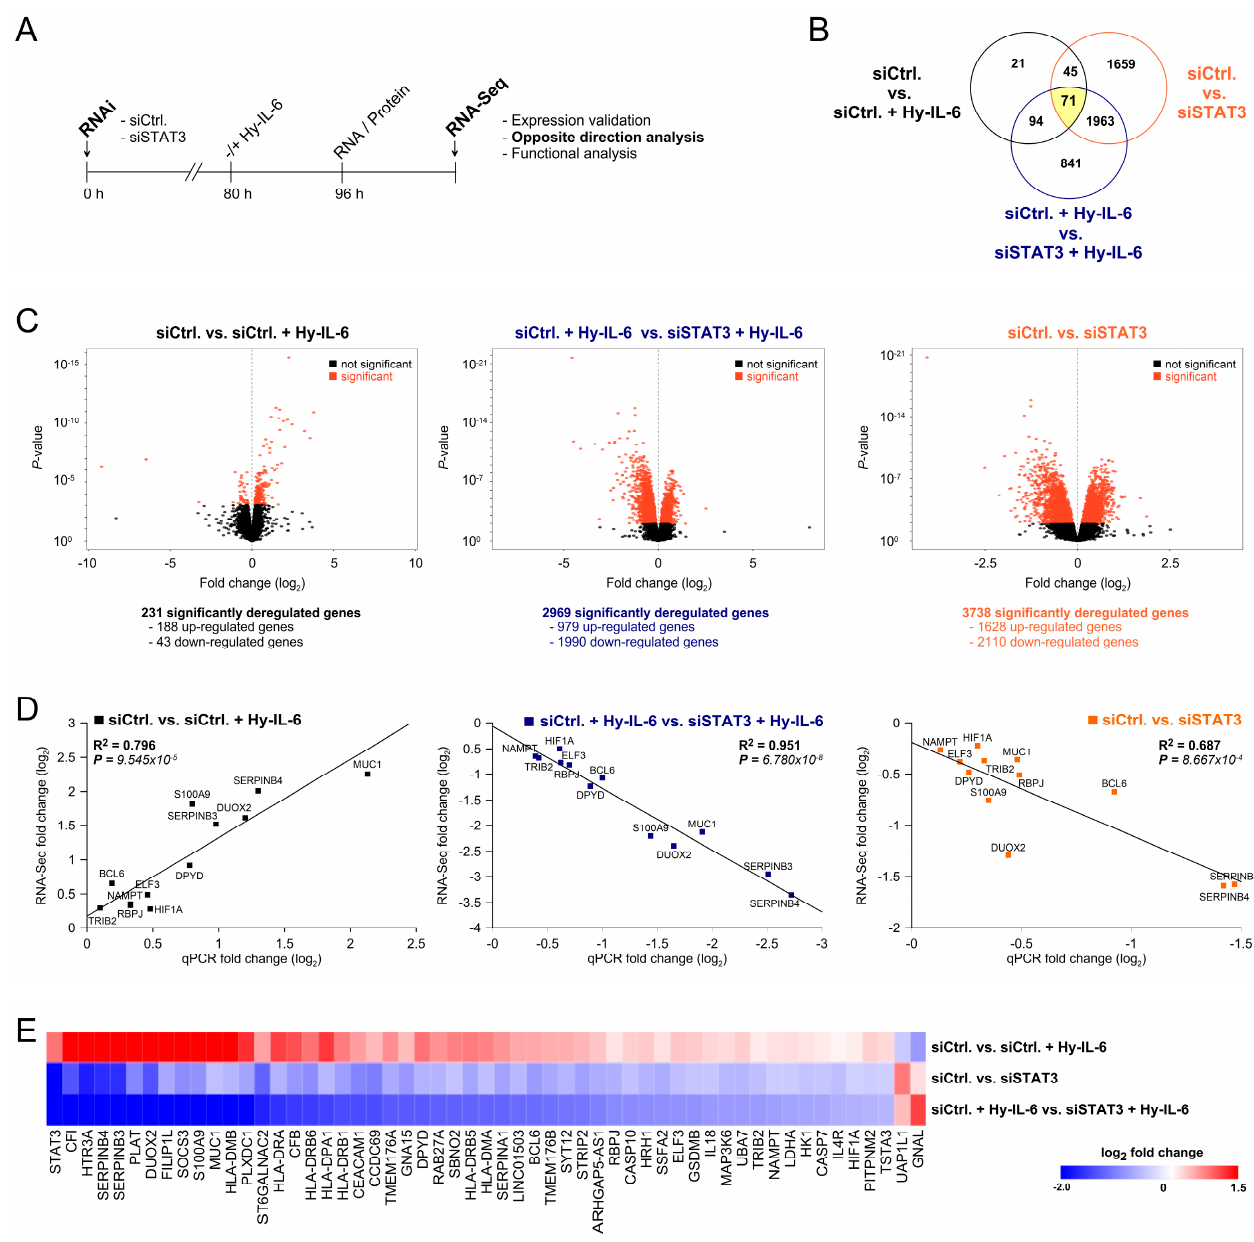
Figure 4. Target genes of the gp130/STAT3 axis. ( A ) RNA-Seq-based detection of STAT3 target genes in SW837 cells with basic or silenced STAT3 expression in the presence or absence of Hyper-IL-6. ( B ) Venn diagram of differentially expressed genes under indicated conditions ( n = 3). RNA-Seq revealed 231 (siCtrl. vs. siCtrl. + Hy-IL-6, left panel), 2969 (siCtrl. + Hy-IL-6 vs. siSTAT3 + Hy-IL-6, middle panel), and 3738 (siCtrl. vs. siSTAT3, right panel) significant genes (FDR < 0.05), respectively. ( C ) Volcano plots depicting the number and distribution of differentially up- and down-regulated genes (FDR < 0.05, red dots). ( D ) Linear model analysis correlating mRNA fold changes elucidated by RNA-Seq with qPCR values. p -values were calculated using Pearson’s correlation. ( E ) Expression profiles of genes fulfilling the Opposite Direction Analysis criteria of being upregulated on stimulation with Hyper-IL-6, and downregulated on STAT3 inhibition, and vice versa (for further information, see Table S3).